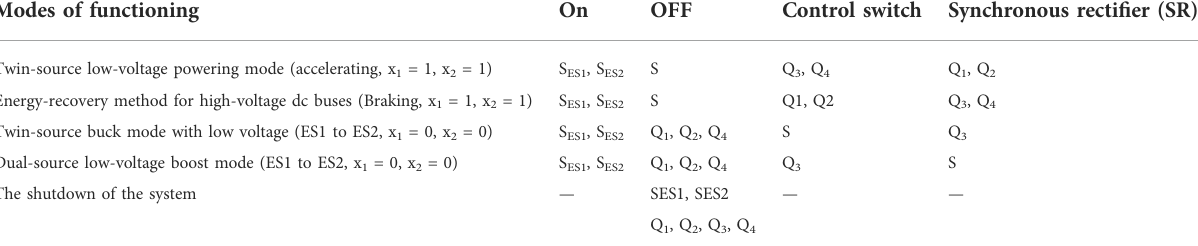
TABLE 2 Devices ’ current state of operation for various operating modes. Modes of functioning